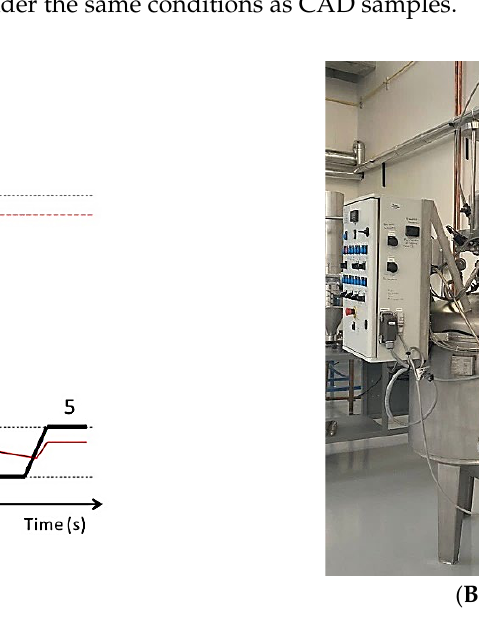
Figure 1. ( A ) Schematic of the time-temperature-pressure profile of a DIC processing cycle. (1) Establishment of the vacuum within the processing reactor; (2) injection of steam at the selected pressure; (3) maintenance of treatment pressure during selected time; (4) instant controlled pressure drop towards vacuum; and (5) establishment of the atmospheric pressure within the processing reactor. ( B ) Laboratory DIC reactor (LABIC0.1, ABCAR-DIC Process; La Rochelle, France). Table 1. Experimental Design Layout for the DIC treatments of maize kernels. Assay No.